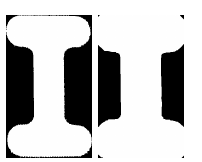
Figure 3. Similar images with PCC = 0.7306 (close to